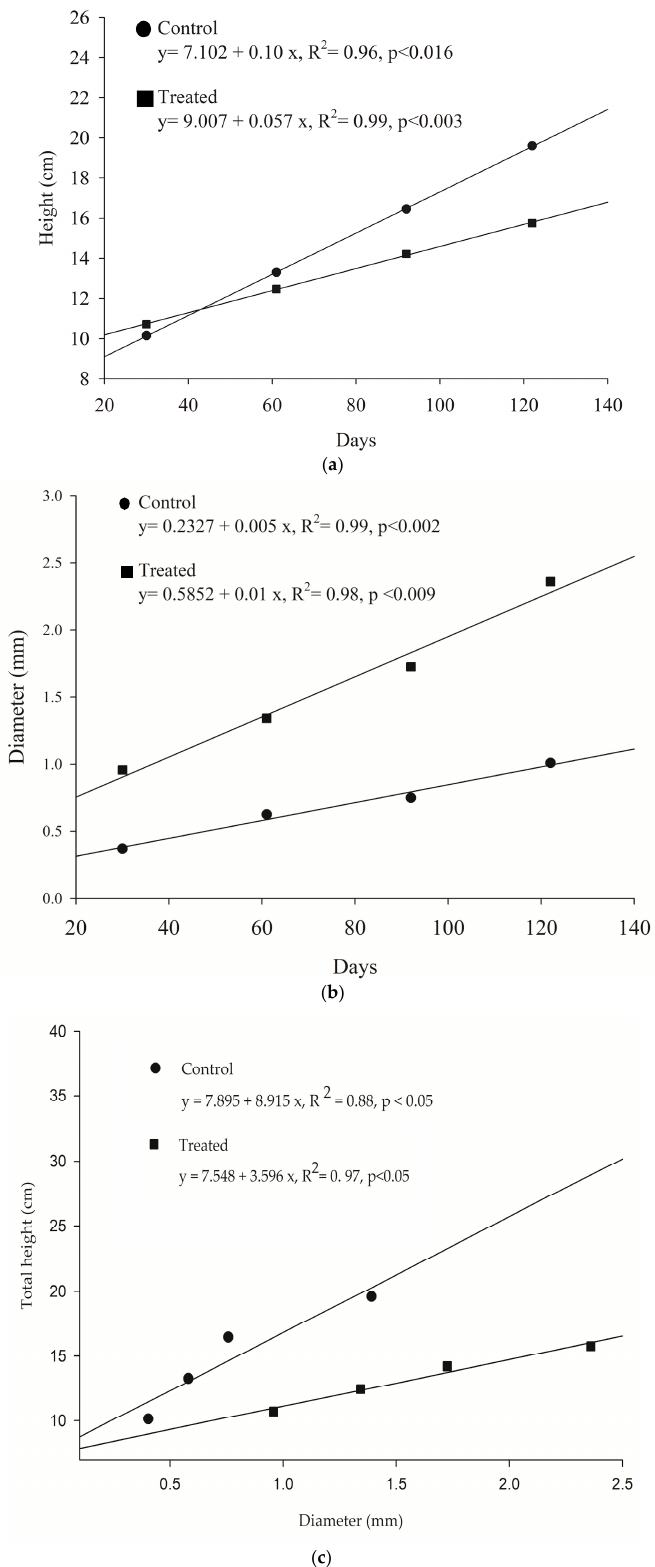
Figure 4. ( a ) Relationship between height and the time in treated plants and control; ( b ) Relationship between diameter and the time in treated plants and control; ( c ) Allometric relationship between height and diameter in treated plants and control.